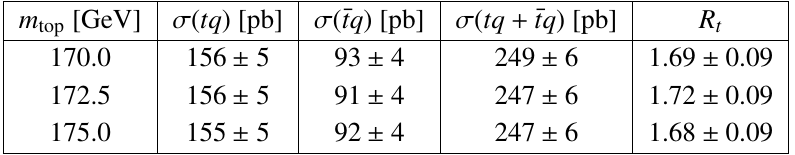
Table 5 . Measured values of the cross-sections (cid:27) ( tq ), (cid:27) (¯ tq ), (cid:27) tot ( tq + ¯ tq ), and R t for di (cid:11) erent simulated top-quark masses. The quoted uncertainties are statistical